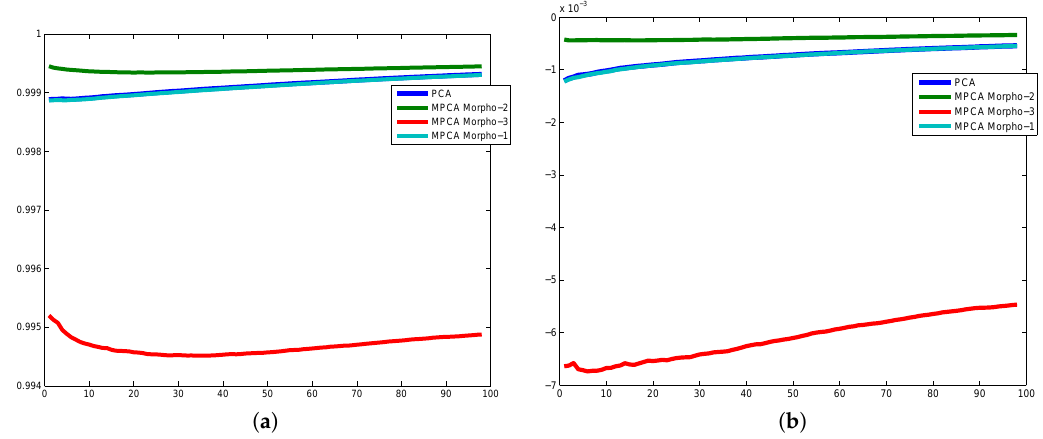
Figure 14. Intrusion/Extrusion parameters for PCA and the different variants of MorphPCA from Pavia hyperspectral image: ( a ) Q ( K ) ; ( b ) B ( K )